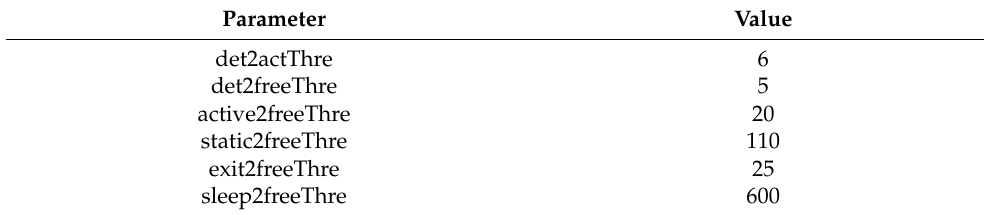
Table 4. GTRACK state transition parameters for pedestrian detection and